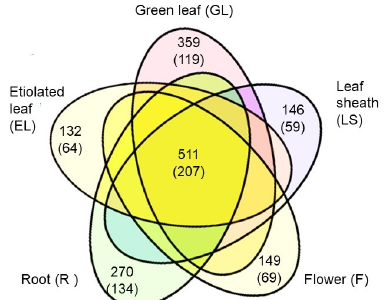
Figure 4. Venn diagram showing the overlap of differentially accumulated proteins in the plasma membrane of the root (R), etiolated leaf (EL), green leaf (GL), leaf sheath (LS), and flower (F). The number of proteins was calculated from the data in Tables S1–S5. The numbers in parentheses indicate the number of proteins assigned to plasma membrane localization, determined using UniProtKB, as listed in Tables S6–S10.